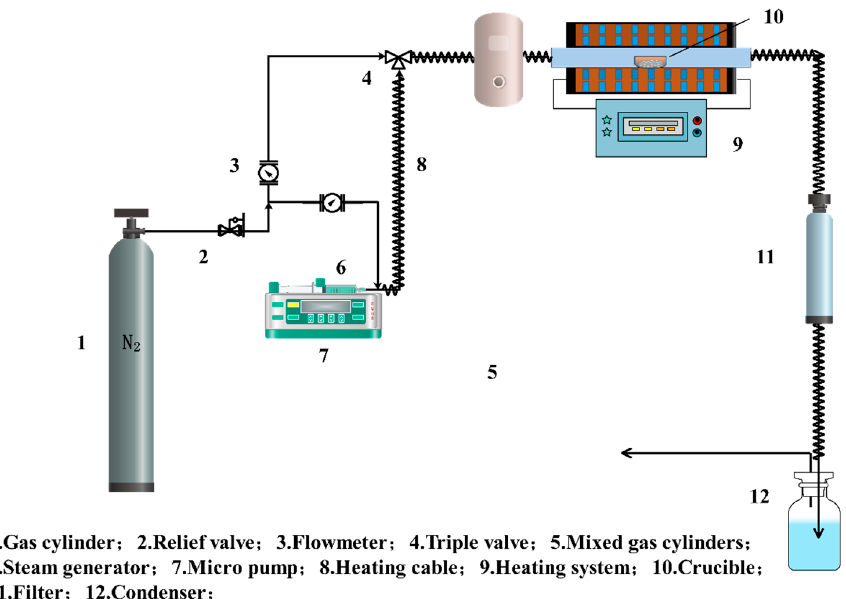
Figure 1. Schematic diagram of the experimental setup for the preparation of activated carbon.